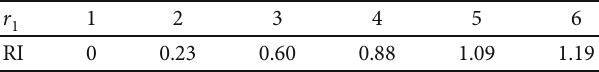
Table 3: RI values of mean random consistency